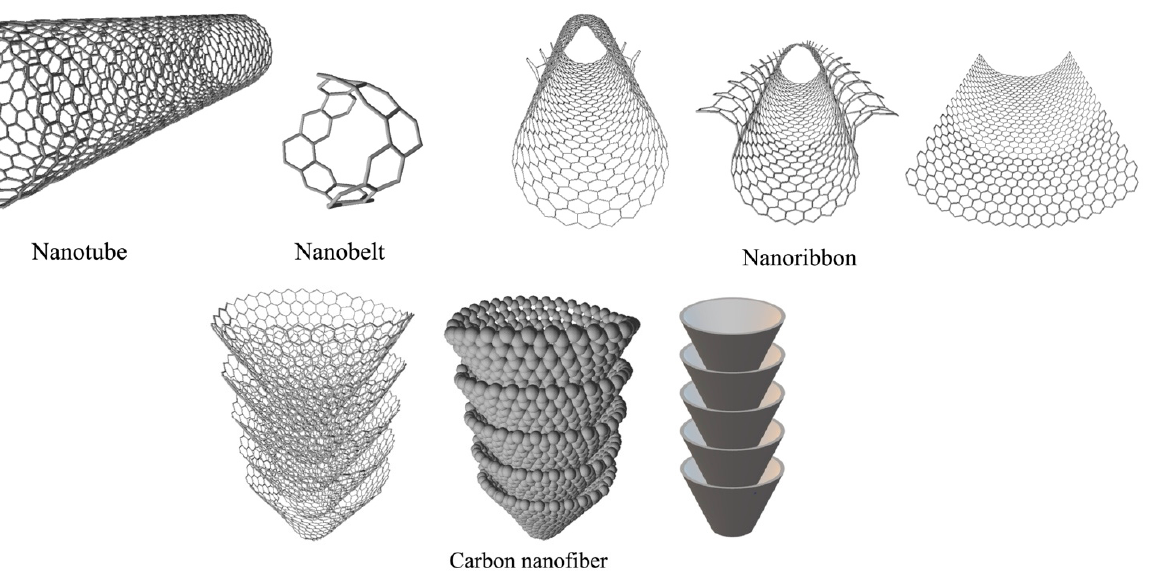
Figure 3. Structures of nanotubes, nanobelts, nanoribbon, and carbon nanofibers.